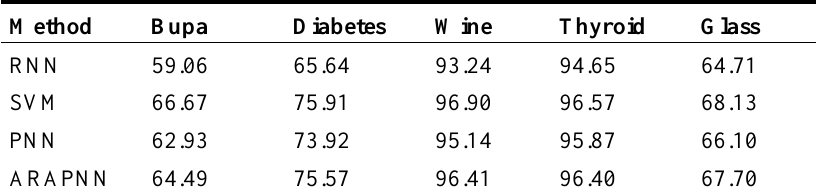
Table 13 . Comparison of the averaged classification rates of RNN, SVM, standard PNN and ARAPNN